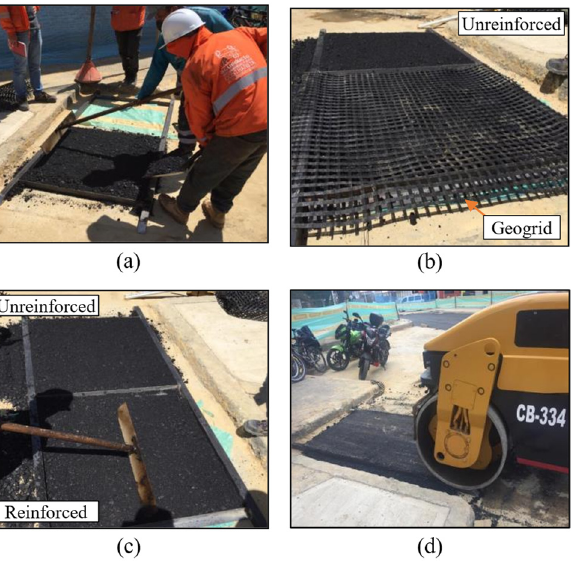
Figure 3. Test sample fabrication process: ( a ) area demarcation, ( b ) location of the geogrid, ( c ) the second asphalt layer, and finally ( d ) the compaction process.